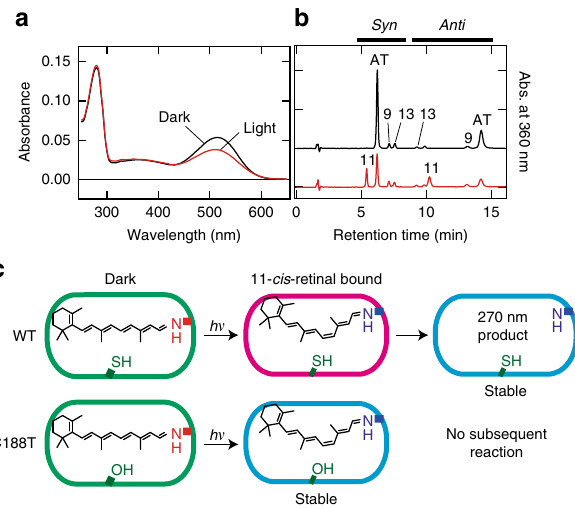
Fig. 3 Amino acid residue responsible for the 270-nm product. a Absorption spectra of Opn5L1NC C188T mutant before (black) and after (red) >500 nm light irradiation for 2 min at 10 °C. Irradiation caused the formation of a 500-nm product, but the 270-nm product was not formed. b HPLC patterns of the retinal oximes extracted from Opn5L1NC C188T mutant before (black) and after (red) >500 nm light irradiation for 2 min. 11- cis -retinal oxime can be extracted from the irradiated pigment. c Reaction scheme of WT Opn5L1NC and its C188T mutant. The WT Opn5L1NC is converted to the 500-nm intermediate by trans -to- cis photoisomerization of the chromophore, followed by formation of the stable 270-nm product, while the C188T mutant is photo-converted to an intermediate similar to the 500-nm intermediate of WT, but this